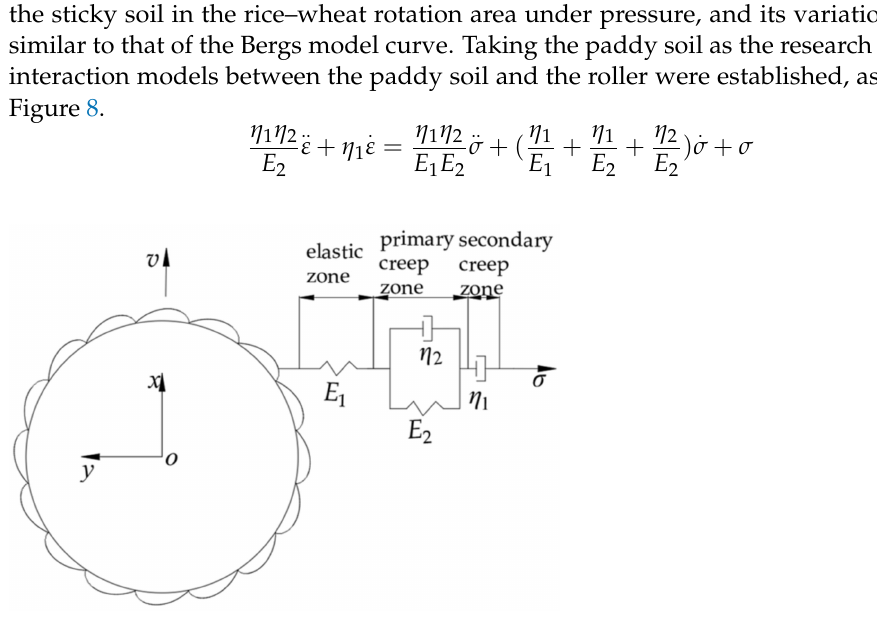
Figure 8. Model of the interaction between roller and soil (the direction of press roller movement is from down to